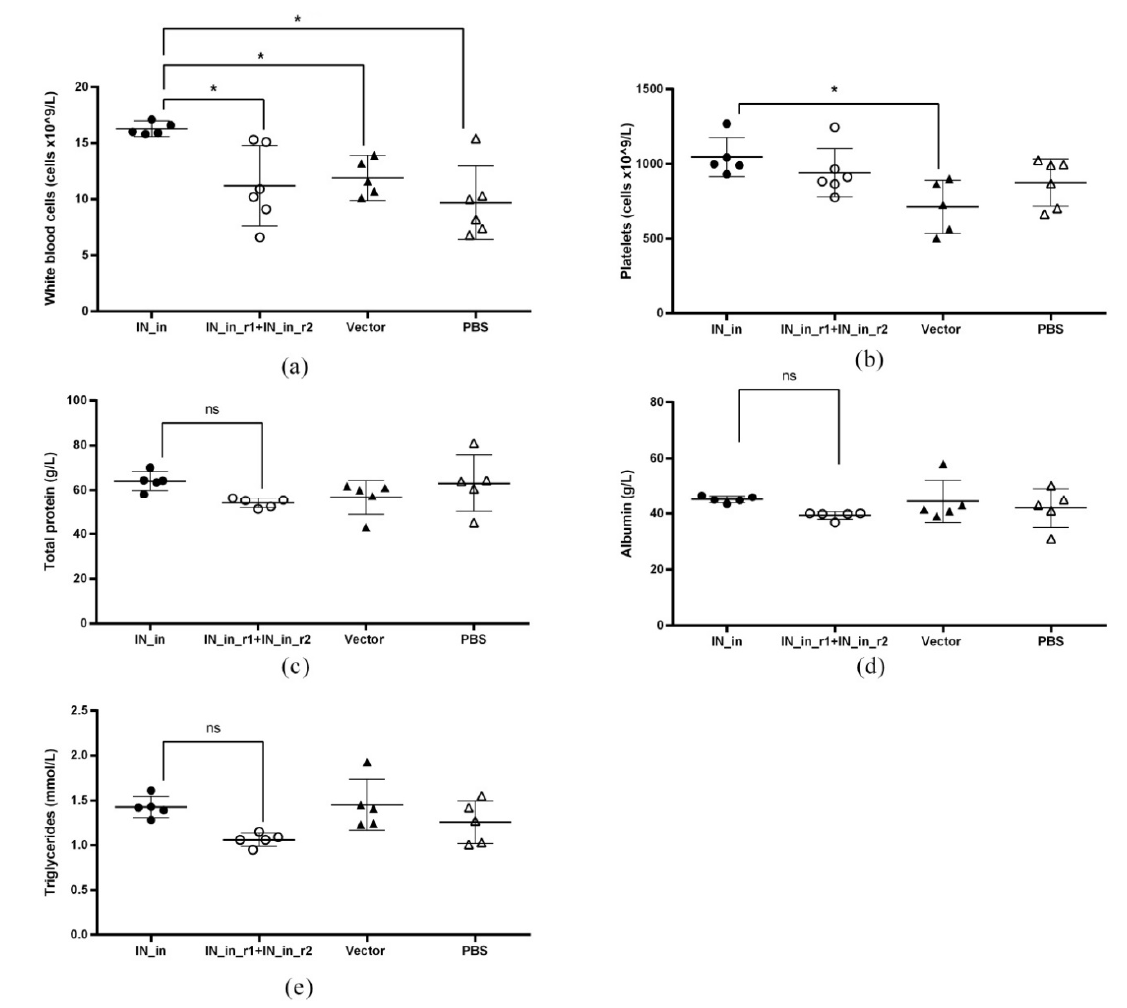
Figure 13. Parameters of biochemical analysis and complete blood counts of mice DNA-immunized with inactivated consensus HIV-1 integrase of clade A (IN_in) and a mixture of drug resistant inactivated IN variants IN_in_r1 and IN_in_r2. Scheme of the experiment is presented in Table I; see Series III. Panels represent individual values of immunized and control mice receiving vector DNA or PBS: white blood cell counts ( a ), platelet counts ( b ), and content of the total protein ( c ), albumin ( d ), and triglycerides ( e ), and average group values with SD. *— p < 0.05 in Kruskal–Wallis and Mann–Whitney tests with Bonferroni correction.